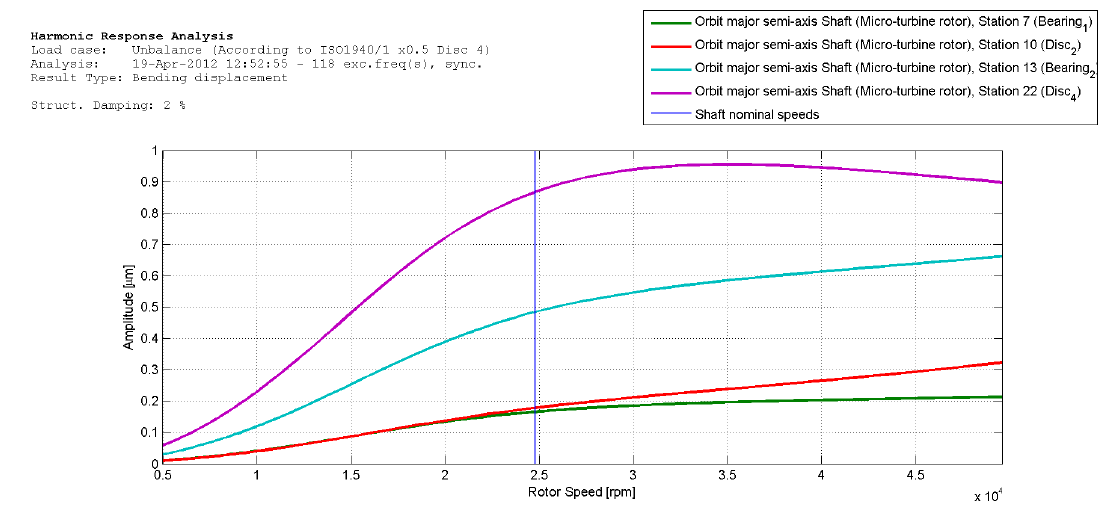
Figure 10: Amplitude of the rotor vibration for the unbalance of the disc No. 4 equal to 0.6 × 10 −6 kg · m.